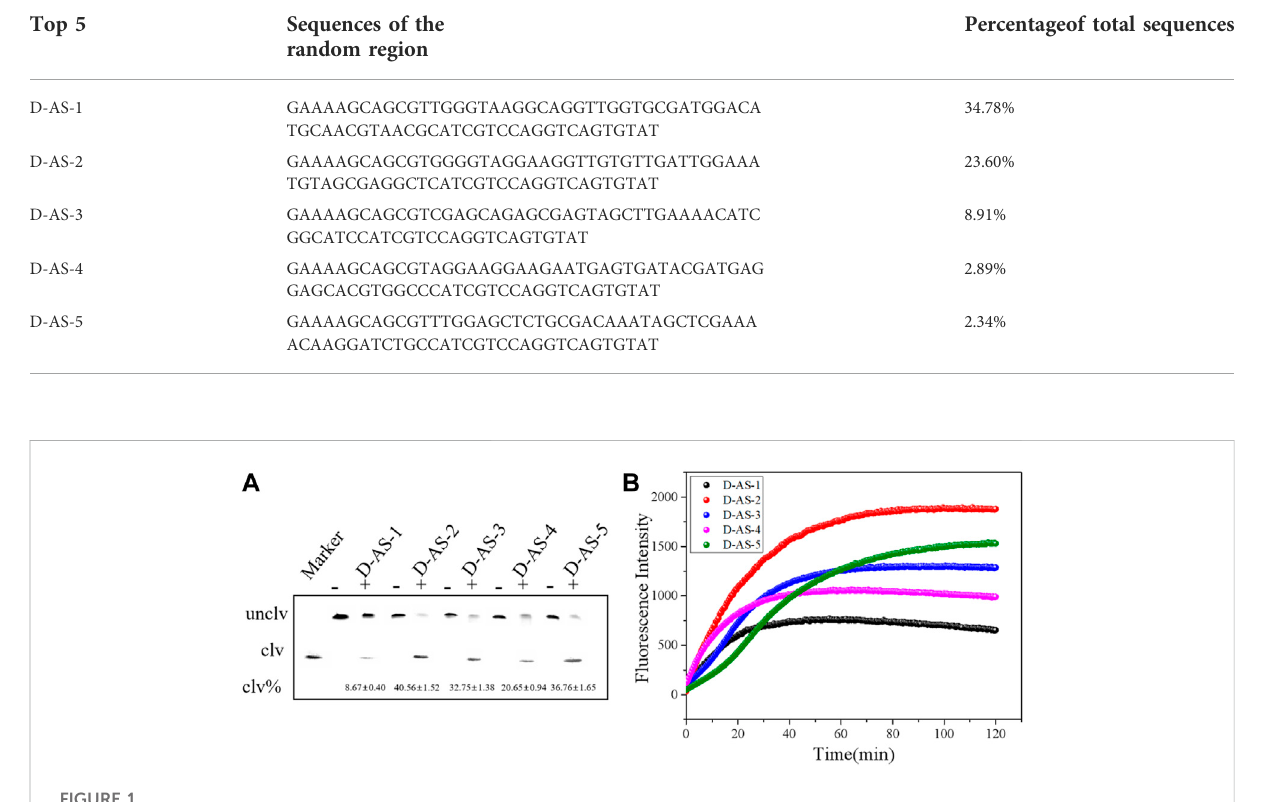
FIGURE 1 (A) 15% dPAGE analysis of candidate sequence activity within 30 min Unclv: Complete DNAzyme sequence; clv: pyrolysis production.clv %:percentage of pyrolysis production; binding chain7.5 μ M and substrate 5 μ M. (B) Fluorescence assay to determine the activity of candidate